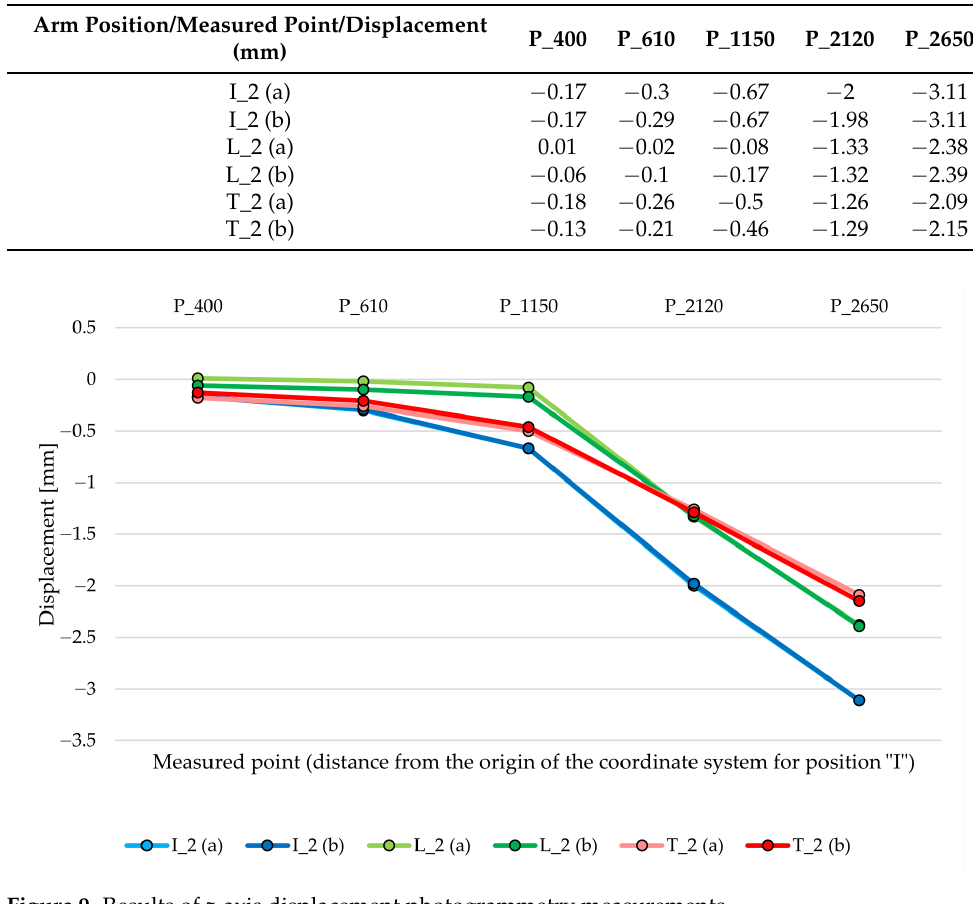
Figure 9. Results of z -axis displacement photogrammetry